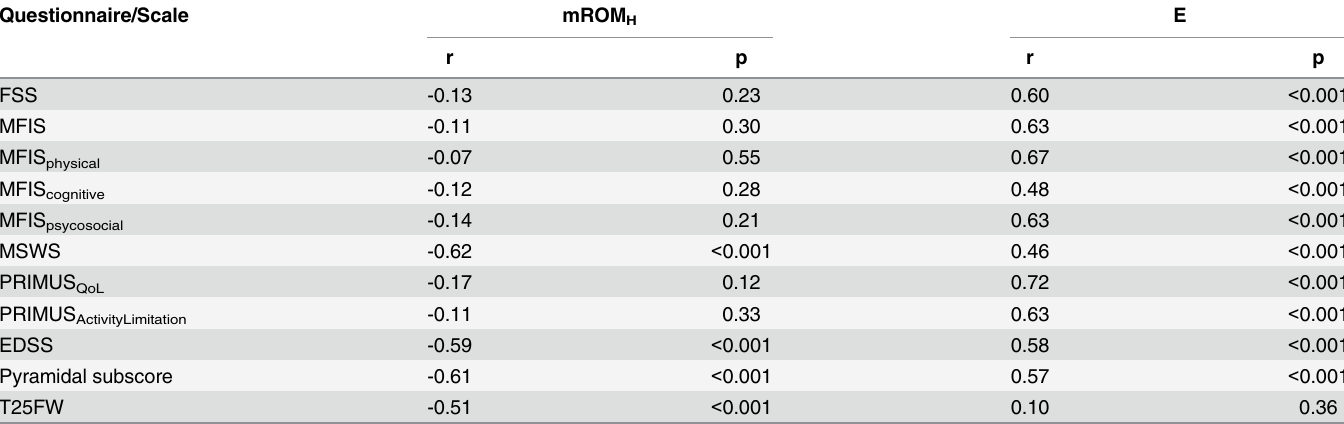
Table 4. Lower Limb Kinematics Correlation with Clinical and Patient-reported Outcomes.